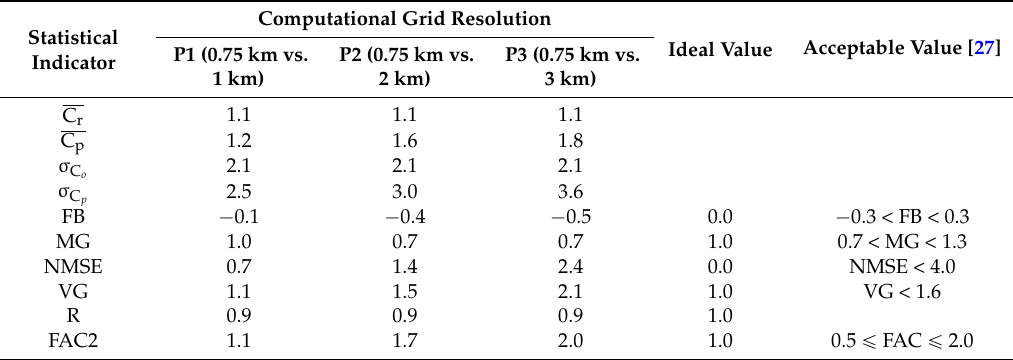
Table 2. Comparison of statistic values for different computational grid